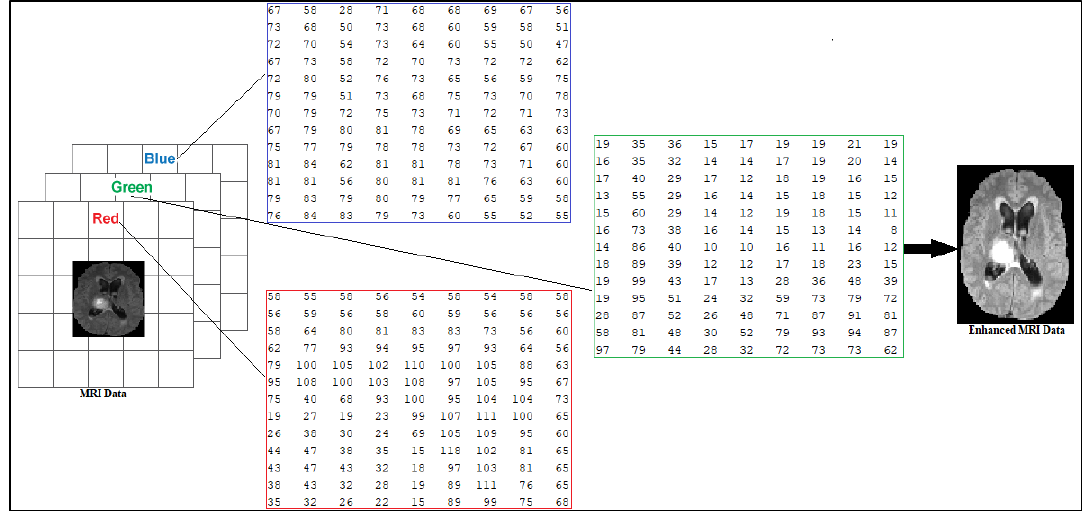
Figure 3. Pre-processing on MRI